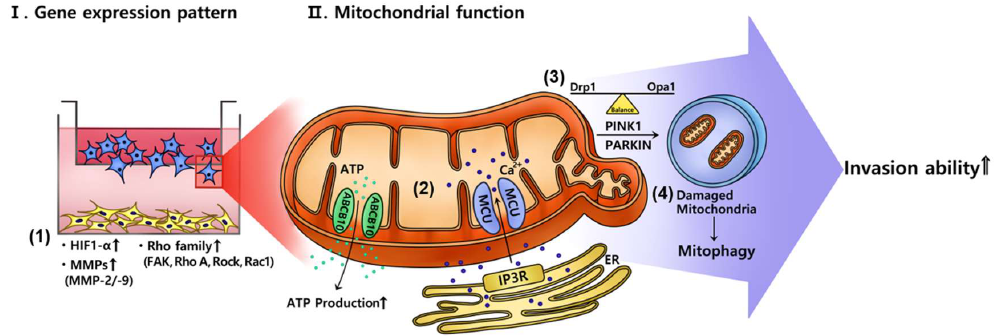
Figure 6. Schematic illustration of the current working hypothesis. The gene expression pattern ( I ) showed that PD-MSCs improve trophoblast invasion via various gene expression. (1) PD-MSCs trigger trophoblast invasion via upregulating HIF1 α and activating MMPs and the Rho family signaling pathway. The mitochondrial function ( II ) indicated that PD-MSCs regulate dynamic mitochondrial function including ATP synthesis, calcium transfer and mitophagy in invaded trophoblast cells. (2) PD-MSCs regulate the mitochondrial function of invasive trophoblasts. Particularly, the mRNA expression of both MCU and IP3R, transporters that move calcium ions though the mitochondria and ER, is upregulated in invasive trophoblasts. Additionally, PD-MSCs increase the mRNA expression of ABCB10, which is involved in ATP production, in invasive trophoblasts. (3) PD-MSCs regulate mitochondrial fragmentation via maintaining the balance between fission and fusion in trophoblasts. (4) PD-MSCs trigger mitochondrial autophagy in trophoblasts via upregulating PINK1 and PARKIN expression. Finally, PD-MSCs promote trophoblast invasion via regulating mitochondrial dynamics, including ATP production and